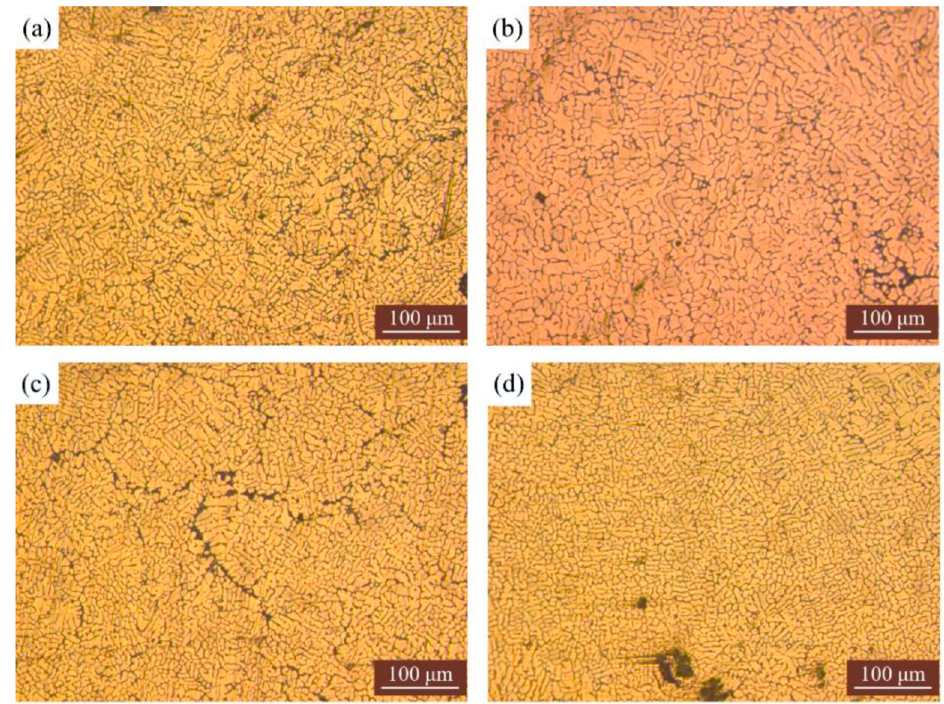
Figure 10. Microstructure of the arc area on the top of the additive sample with the different ultrasonic peening scanning speeds: ( a ) no ultrasonic impact; ( b ) 6 mm/s; ( c ) 4 mm/s; ( d ) 2 mm/s, reproduced or adapted from [81], with permission from MDPI, 2022.